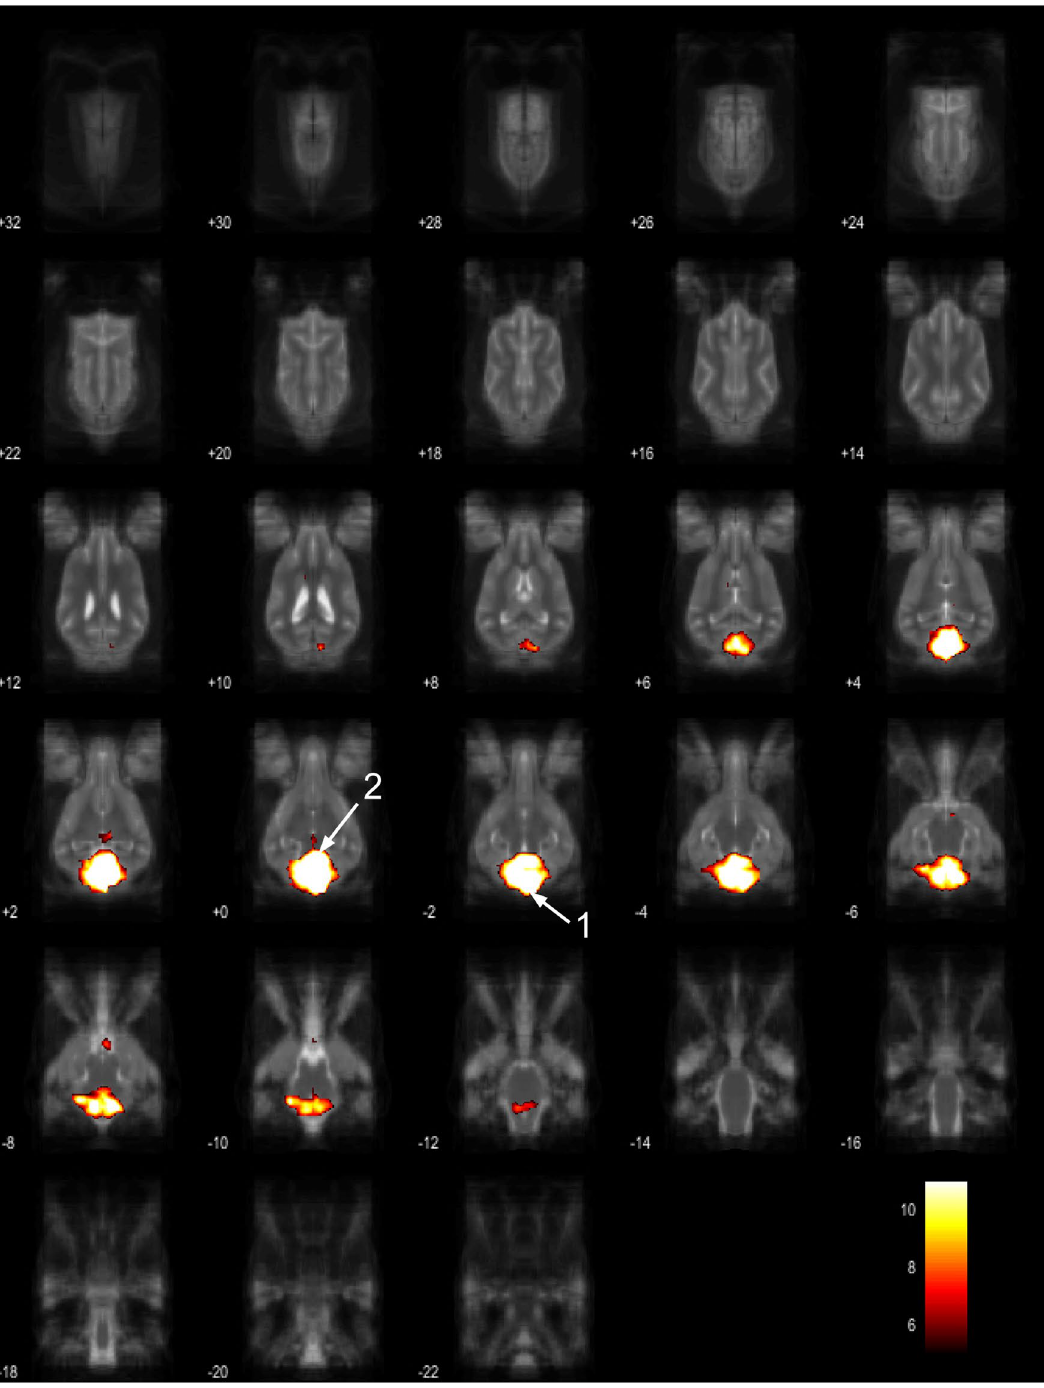
the parahippocampal gyrus. These regions correspond to the primer sensorimotoric, premotoric and supple- menter motoric regions of the dog brain. Component L (Fig. 15) covered primary and secondary visual areas, sensory and visual-sensorimotor cortices, namely the marginal gyrus, the ectomarginal gyrus, the suprasylvian gyrus and occipital gyrus. Component M (Fig. 16) included primary visual areas, such as the occipital gyrus, ectomarginal gyrus and caudal suprasylvian gyrus. Component L & M both are networks consisting of regions involved in visual processing. Component N (Fig. 17) was classified as a noise component corresponding to large